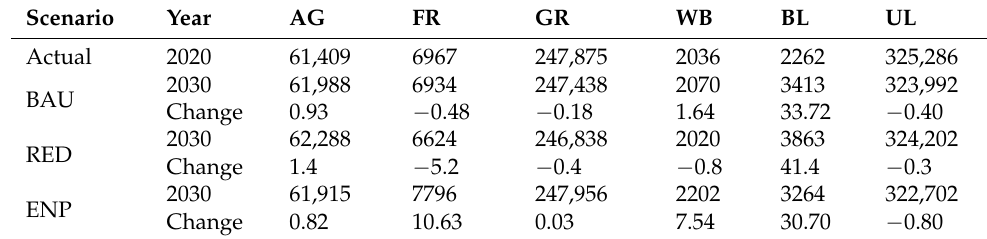
Table 9. LULC dynamics in actual and predicted scenarios.